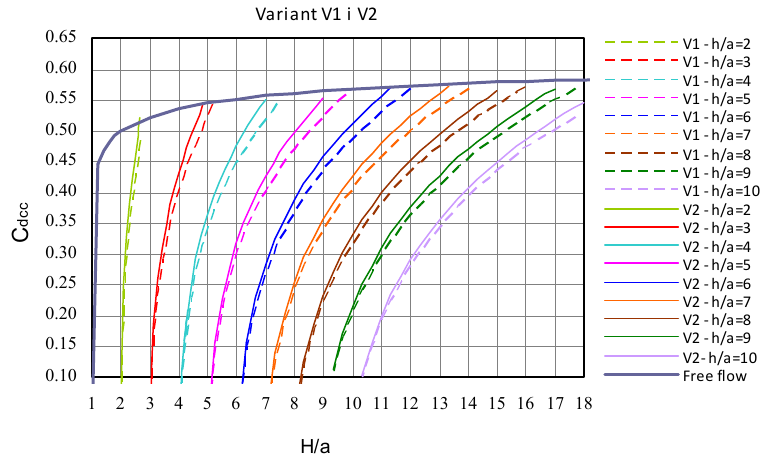
Figure 14. Nomogram to calculate the discharge coefficients C dcc developed on the basis of dependence (5), including correction (13) for experiments performed in cases V1 and V2.